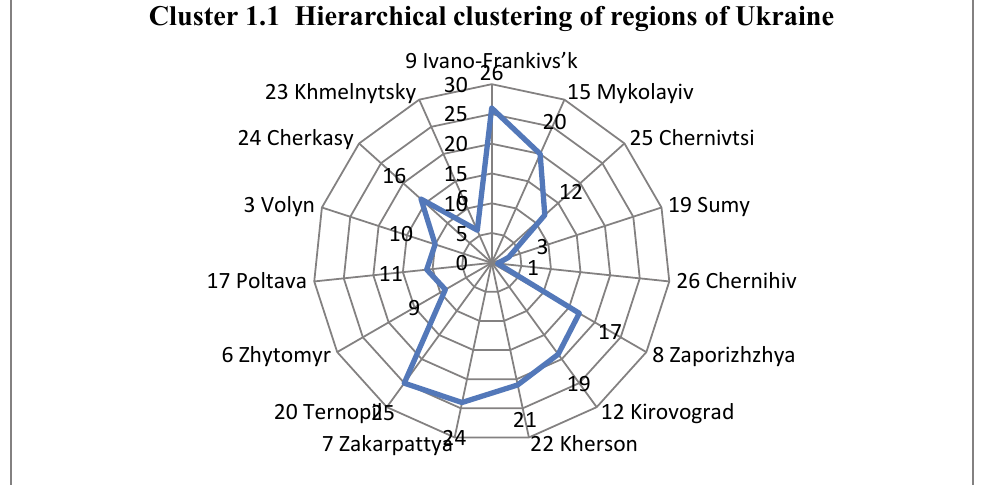
Score ( K i ) Rank Characteristics of evaluation